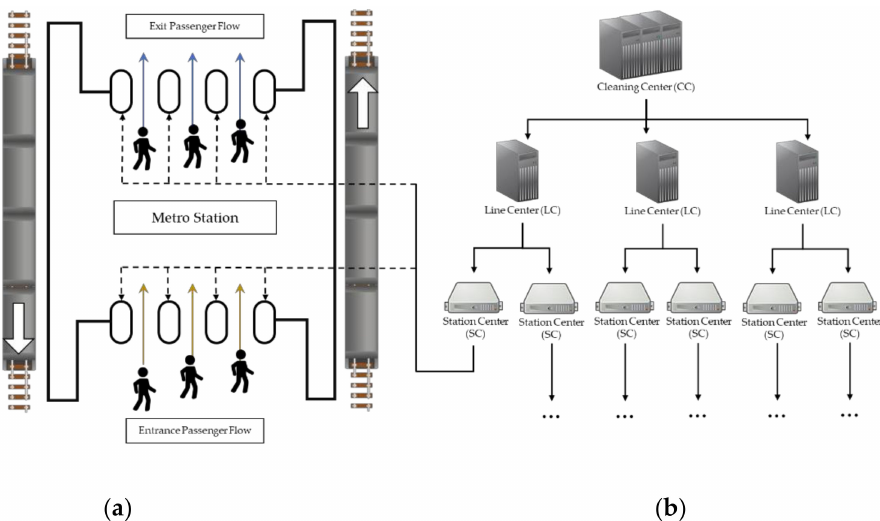
Figure 1. Brief structure of an automatic fare collection (AFC) system: ( a ) metro station and ( b ) computer